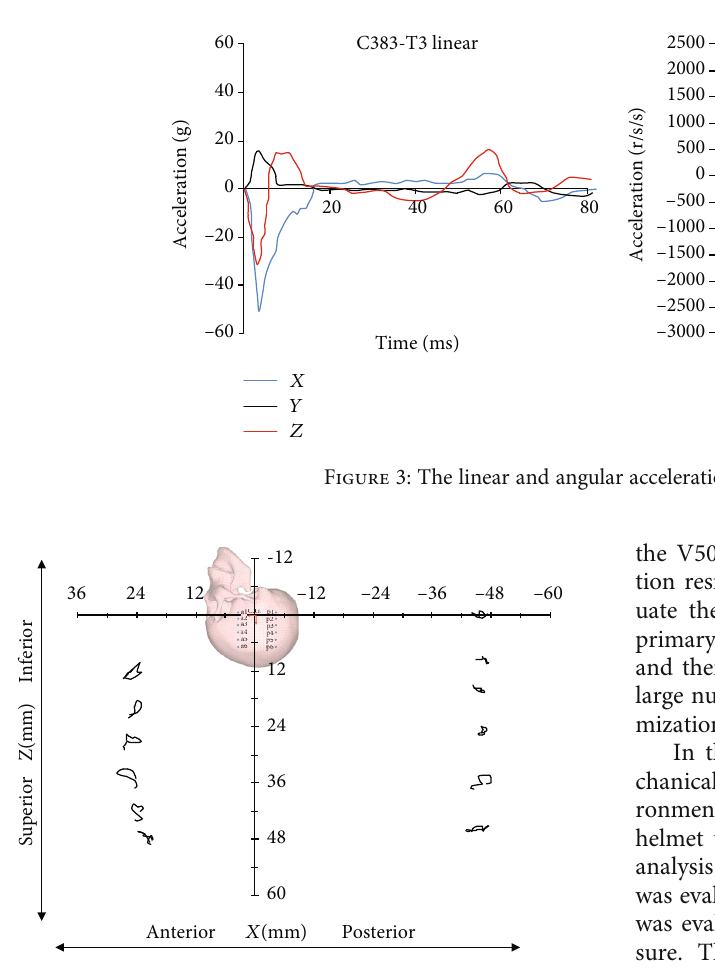
Figure 4: Simulation of brain skull relative